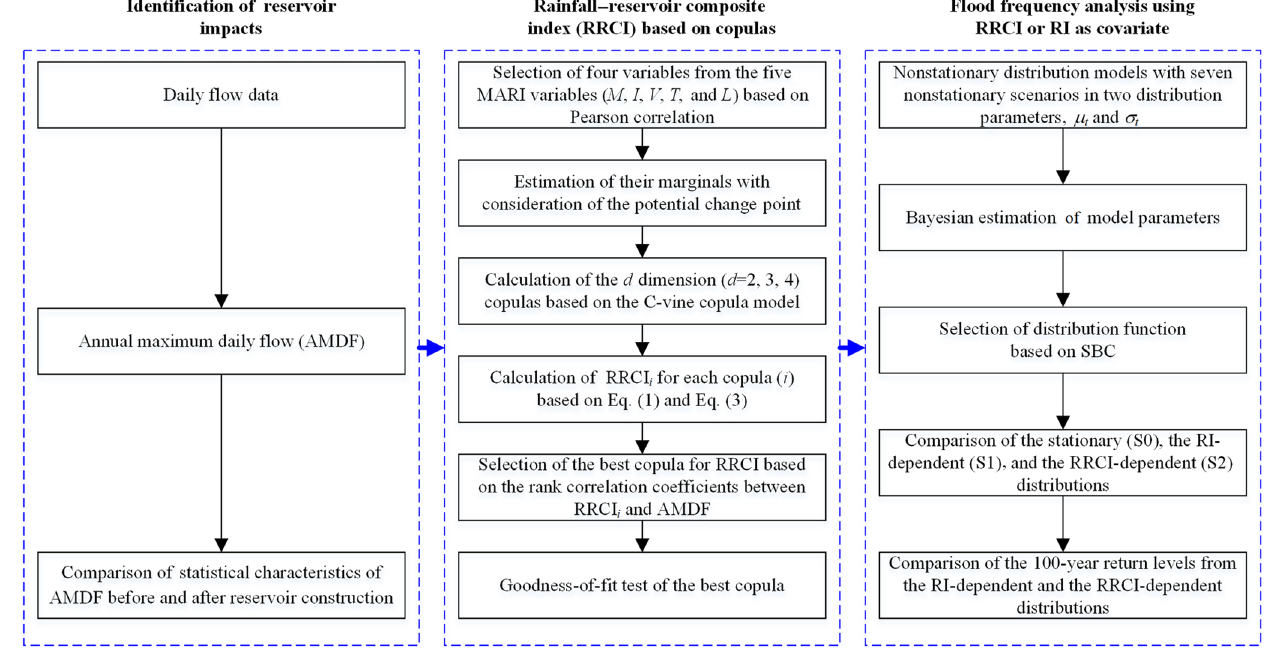
Figure 1. Flowchart of the nonstationary covariate-based flood frequency analysis using the rainfall–reservoir composite index